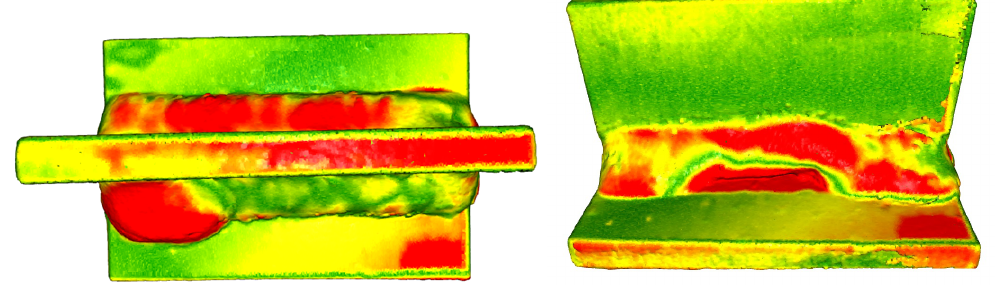
Figure 6. Welding defects: excessive convexity defect ( left ) and intermittent undercut defect ( right ), based on color temperature